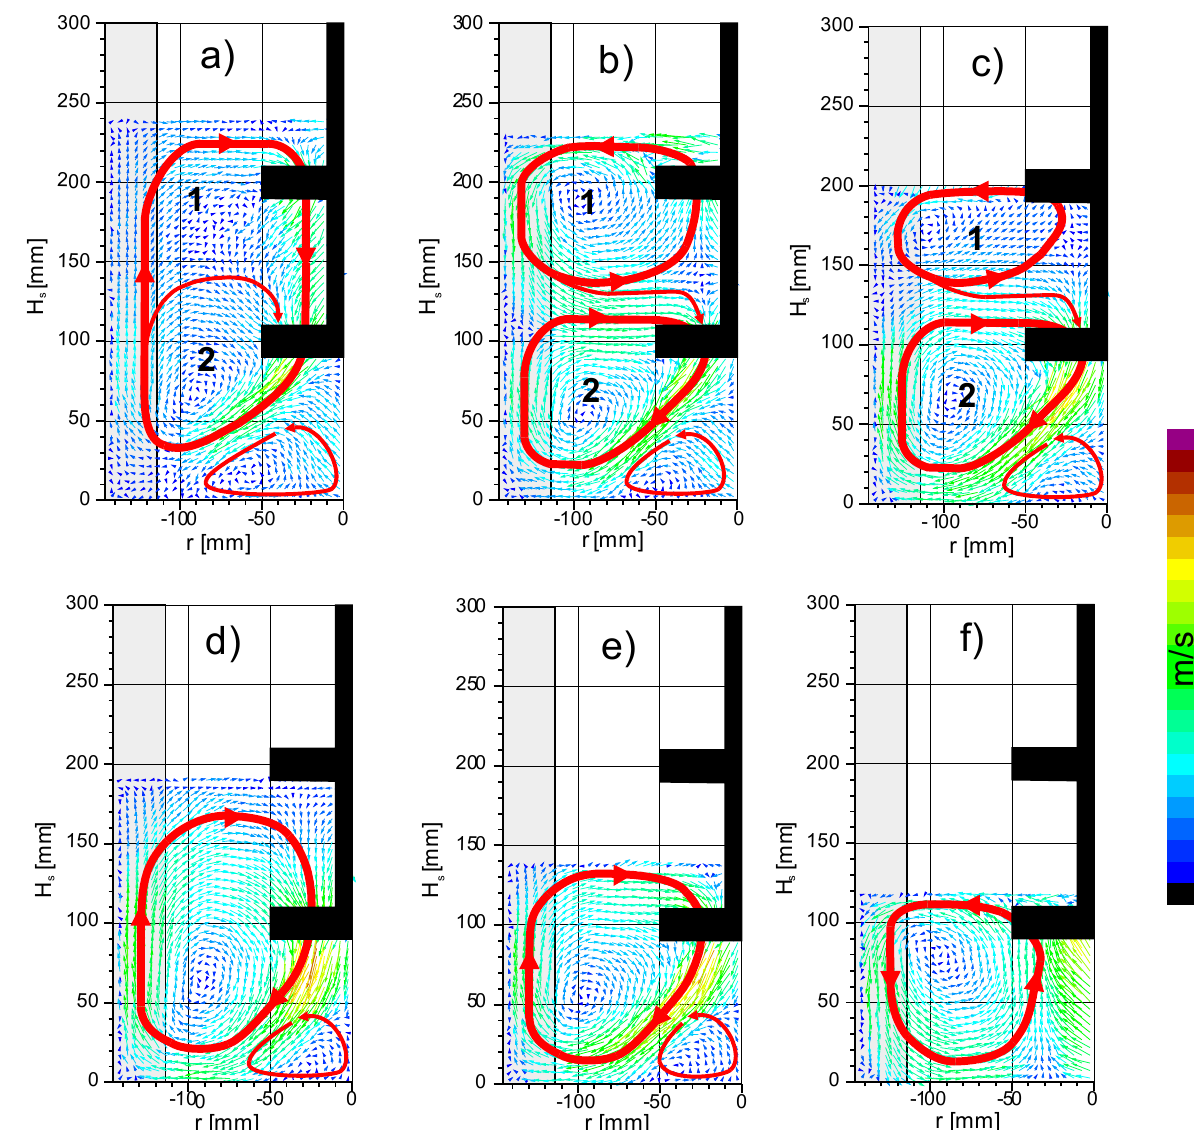
Figure 4. Velocity distributions in the r-z plane and a secondary circulation for the different heights of the liquid level H the mixing tank: ( a ) H s = 240 mm, ( b ) H s = 230 mm, ( c ) H s = 200 mm, ( d ) H s = 190 mm, ( e ) H s = 140 mm, ( f ) H s = 120